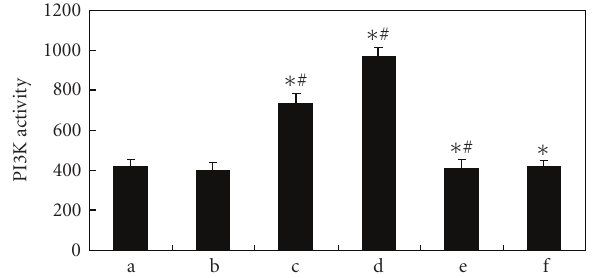
Figure 4: In PI3K activity assay, it was found that hypercholes- terolemic serum could significantly enhance PI3K activity with a dose-dependent manner, which could be reversed by wortmannin. a: serum free medium; b: normal rabbit serum; c: low concentration of hypercholesterolemic serum (0.04 mMol/L); d: high concen- tration of hypercholesterolemic serum (0.32mMol/L); e: c plus 100nMol/L wortmannin; f: d plus 100 nMol/L. ∗ represents P < . 05 compared with serum-free medium control; # represents P < . 05 compared with the previous